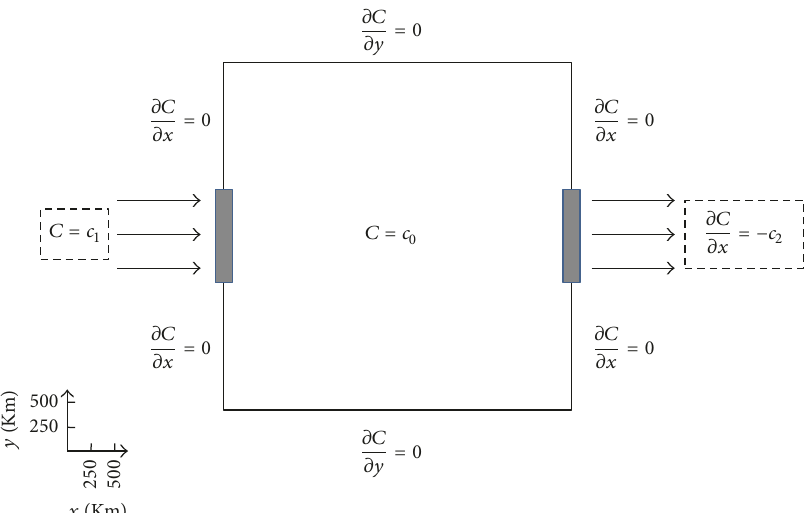
Figure 3: The initial and boundary conditions of water pollutant dispersion model in opened-closed reservoir.